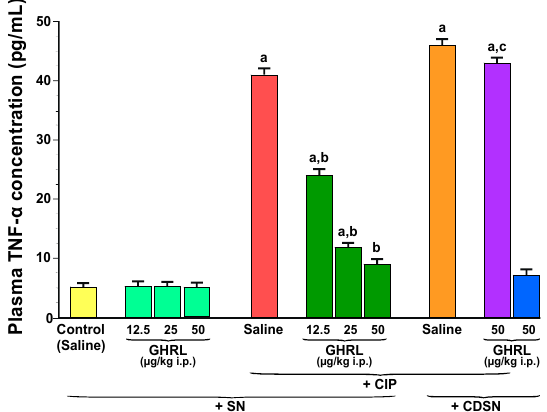
Figure 6. Effect of saline or ghrelin (GHRL) given intraperitoneally at a dose of 12.5, 25 or 50 μ g/kg and cerulein-induced pancreatitis (CIP) on plasma concentration of tumor necrosis factor- α (TNF- α ) in sensory nerves-intact rats (SN) or rats with capsaicin deactivation of sensory nerves (CDSN). a p < 0.05 compared to the control group with intact sensory nerves and without induction of CIP; b p < 0.05 compared to sensory nerves-intact rats with CIP pretreated with saline; c p < 0.05 compared to sensory nerves-intact rats pretreated with GHRL at a dose of 50 μ g/kg prior to CIP. Mean ± SEM from values obtained from 10–15 rats in each experimental group.